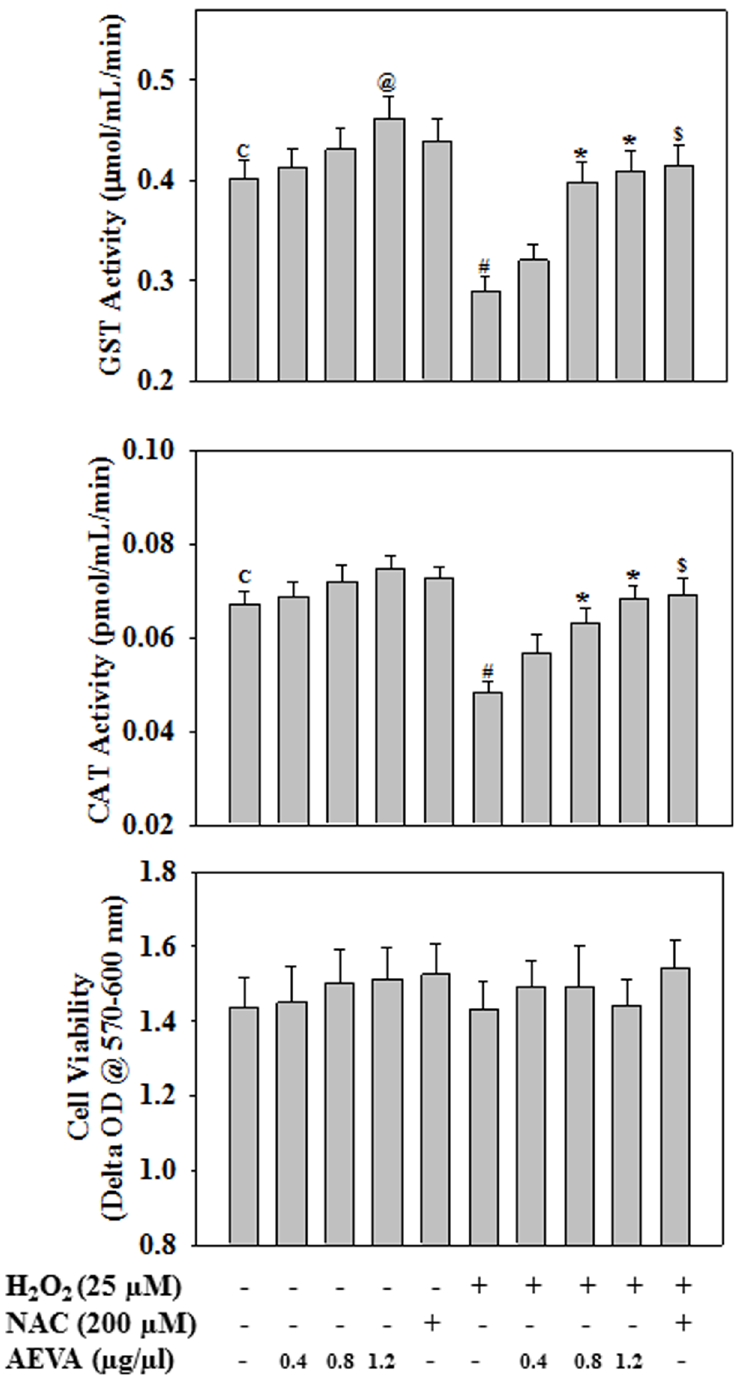
Fig 12. Effect of AEVA or NAC (N-acetyl cysteine, positive control) on GST and CAT enzyme activity in THP-1 monocyte cells. Cells were treated with different concentrations of AEVA (0.4, 0.8, and 1.2 μ g/ μ L) or NAC (200 uM) for 2 h followed by H 2 O 2 exposure (25 μ M) for next 2 h. “ * ” indicates the significant difference between “ H 2 O 2 ” and “ AEVA+ H 2 O 2 ” -treated group( p < 0.05); “ $ ” indicates the significant difference between ” and “ NAC+ H ” -treated group; “ @ ” indicates the significant difference between “ control (C) ” and “ H 2 O 2 2 O 2 “ AEVA (1.2 μ g/ μ L) ” -treated group. Values are mean ± SE (n =